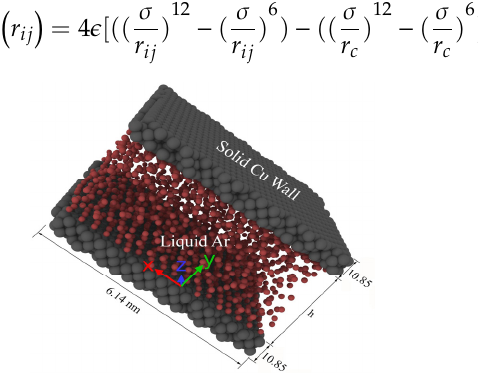
Figure 1. Atomistic model of the simulation domain.